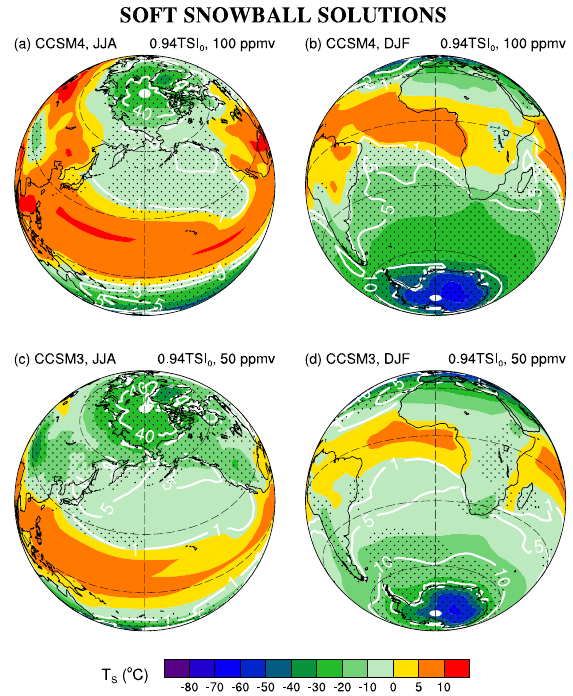
Fig. 7. Modern soft Snowball Earth solutions in CCSM4 (upper panel, 94% solar radiation and 100ppmv CO 2 ) and in CCSM3 (lower panel, 94% solar radiation and 50ppmv CO 2 ). Surface air temperature ( ◦ C, color shaded), sea ice thickness (m, white lines) and snow-covered regions ( > 0.04m, stippled) in June-July-August (JJA, a, c ) and in December-January-February (DJF, b, d